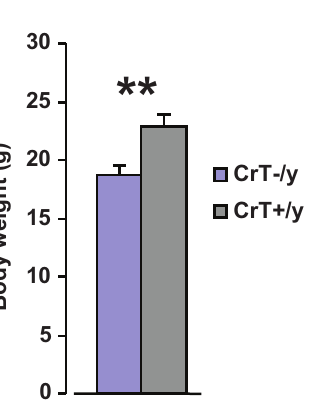
Figure 2. Body weight is lower in CrT –/y animals at two months of age. At P60 the weight of CrT –/y mice was significantly reduced compared to CrT +/y animals (CrT –/y : 18.75 ± 0.78 g, CrT +/y : 22.77 ± 0.90 g; t test, p < 0.01). *, statistical significance. Error bars,